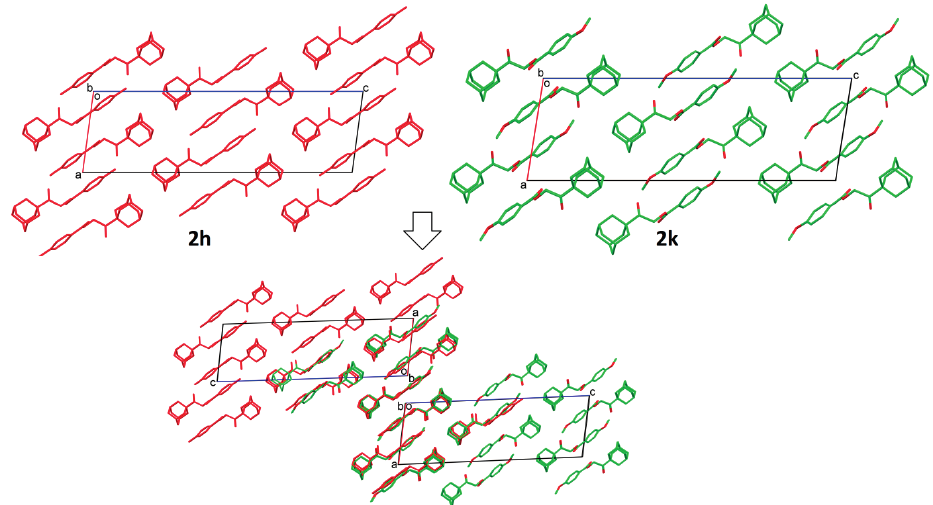
Figure 5. Crystal packing comparison of Compounds 2h and 2k .